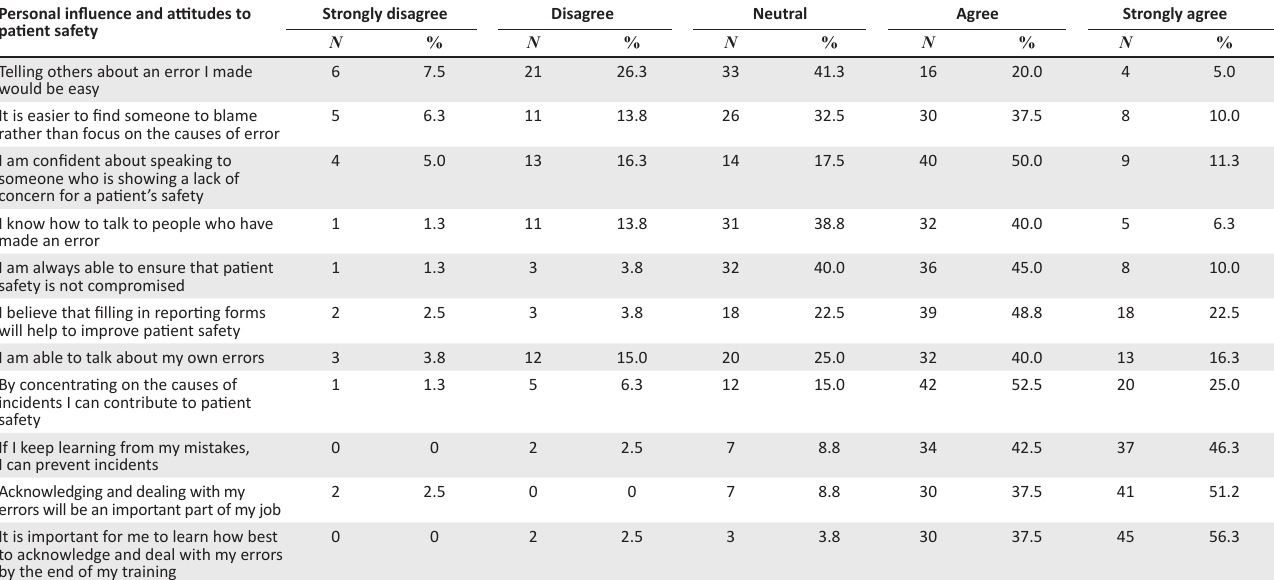
TABLE 2: Personal influence and attitudes to patient safety ( n =